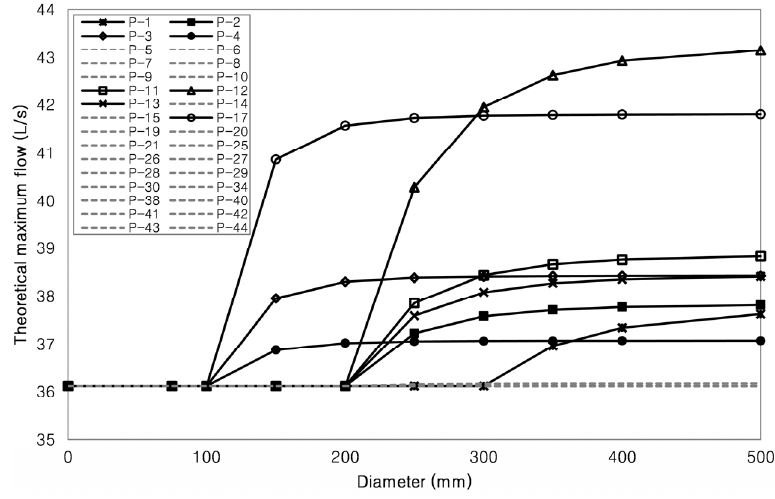
Figure 10. Network capacity increase based on diameter change.